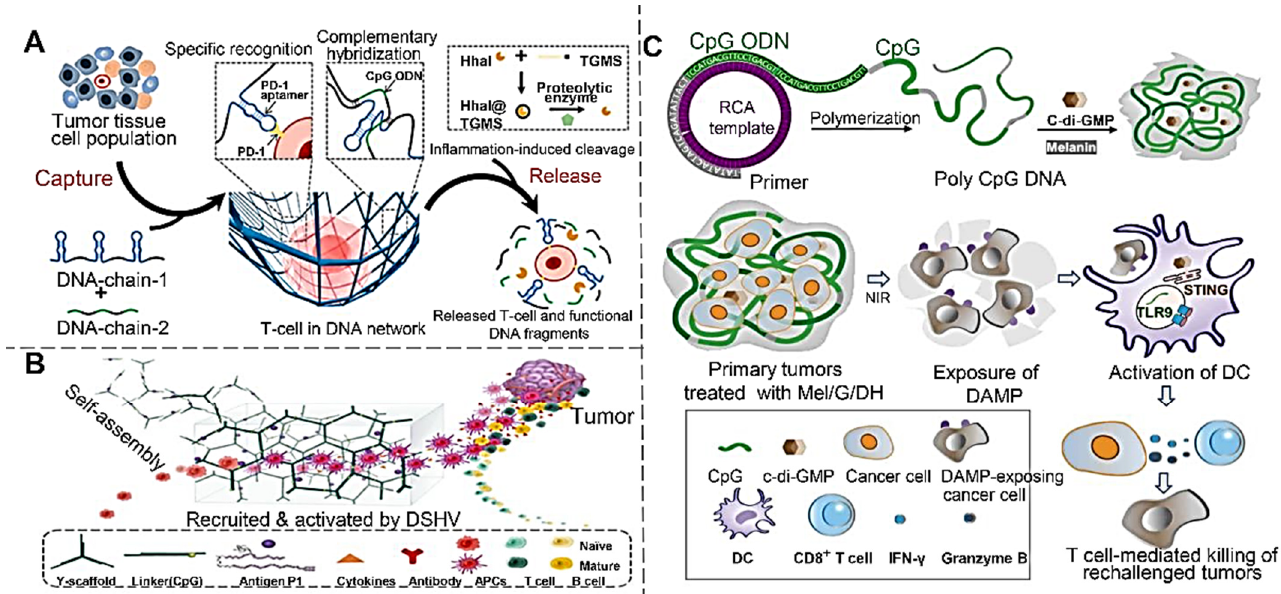
Figure 6. The application of DNA hydrogel in immunotherapy: ( A ) DNA hydrogel construction for the capture of tumor-infiltrating T cells. (Adapted with permission from [80]. Copyright (2021) American Chemical Society.) ( B ) Schematic illustration of the DSHV system loaded with CpG and antigen P1 to recruit and activate APCs. (Adapted with permission from [89]. Copyright (2018) American Chemical Society.) ( C ) Melanin-loaded DNA adjuvant hydrogel for photothermal immunotherapy. (Adapted with permission from [98] and used under a Creative Commons Attribution 4.0 International License.)